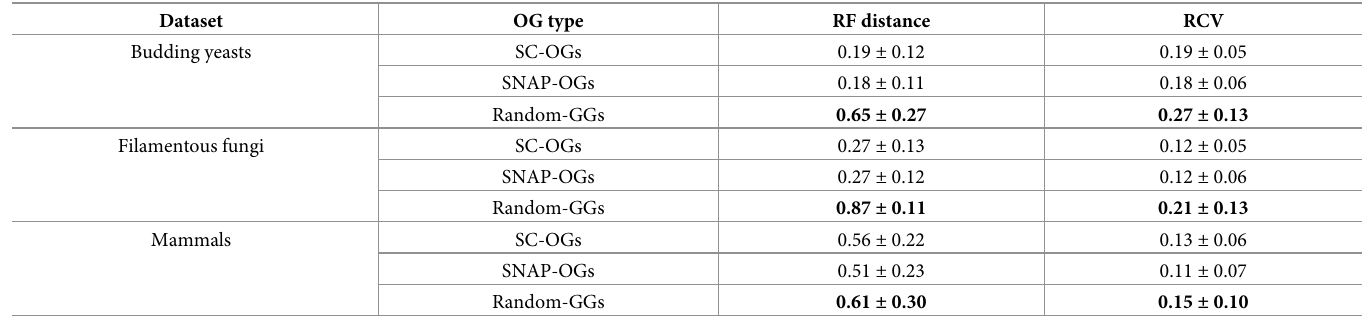
Table 1. SC-OGs and SNAP-OGs are more accurate and have less compositional biases than Random-GGs. Dataset